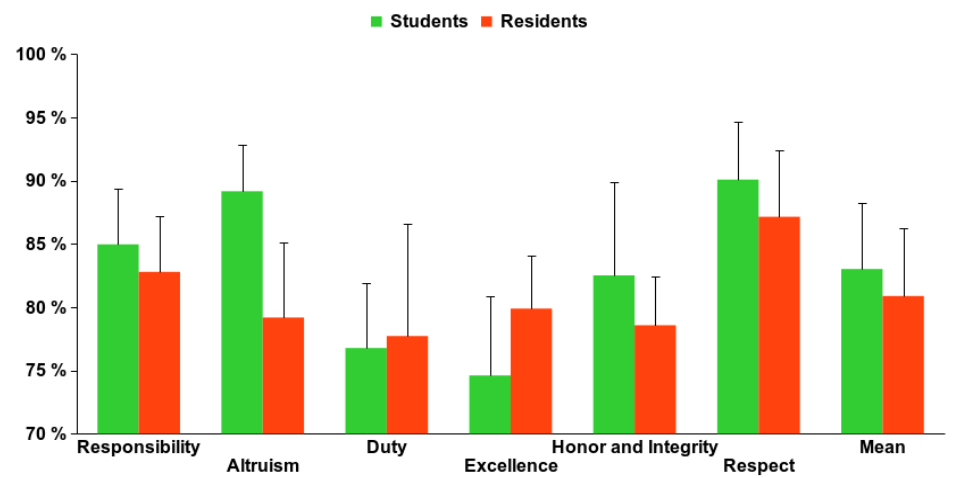
Figure 5. Comparison between positive answers in Residents and Medical Students.